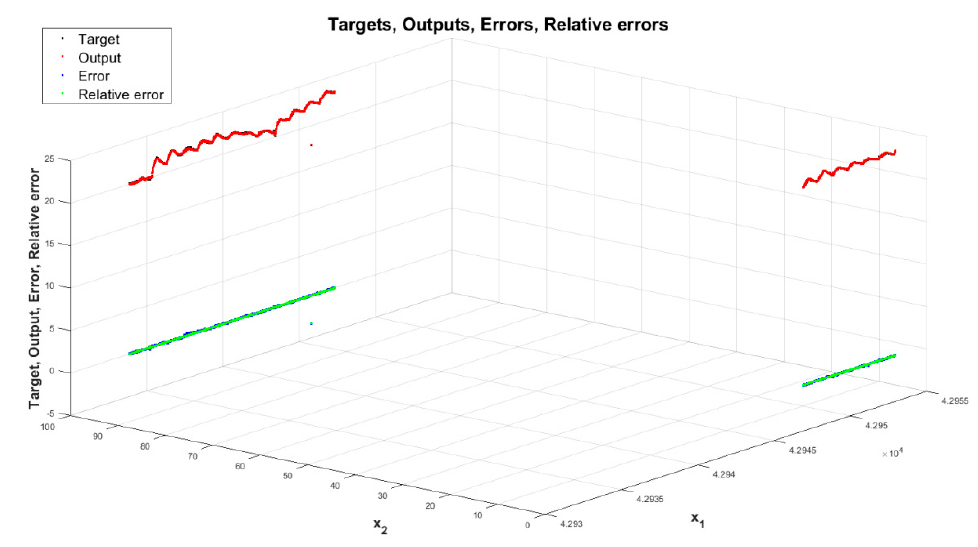
Figure 15. An illustrative example of the function y = f ( X ) for di ff erent sets of x 1 and x 2 arguments. The function drawn on the background of y i (target), absolute errors ( e i ), and relative errors ( RE ) made by the functional mapping y = f ( X ) .